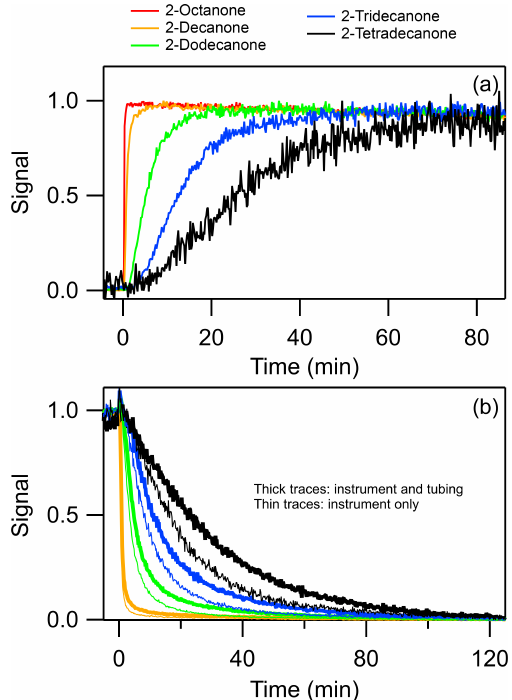
Figure 2. (a) PTR-MS time profiles measured in response to a step-function increase in the concentration of 2-ketones. All com- pounds were measured simultaneously through 1m of 3/16in. ID PFA Teflon tubing at a flow rate of 0.36Lmin − 1 . Profiles are nor- malized to peak signal. The decline in signal over time is due to drift in instrument response following start-up. (b) PTR-MS time profiles measured in response to a step-function decrease in the concentra- tion of 2-ketones for tubing + PTR-MS (thick lines) and the PTR- MS alone (thin lines). The tubing used was a 3m length of 3/16in. ID PFA Teflon, and the flow rate for both traces was 0.36Lmin − 1 . Profiles are normalized to the equilibrium concentration measured prior to the step change. The signal-to-noise ratio is lower at higher carbon numbers due to gas–wall partitioning in the chamber lower- ing sample concentration as well as mass discrimination within the PTR-MS quadrupole mass analyzer. For visual clarity the profiles for 2-octanone are not shown since they overlap with the profiles for 2-decanone.